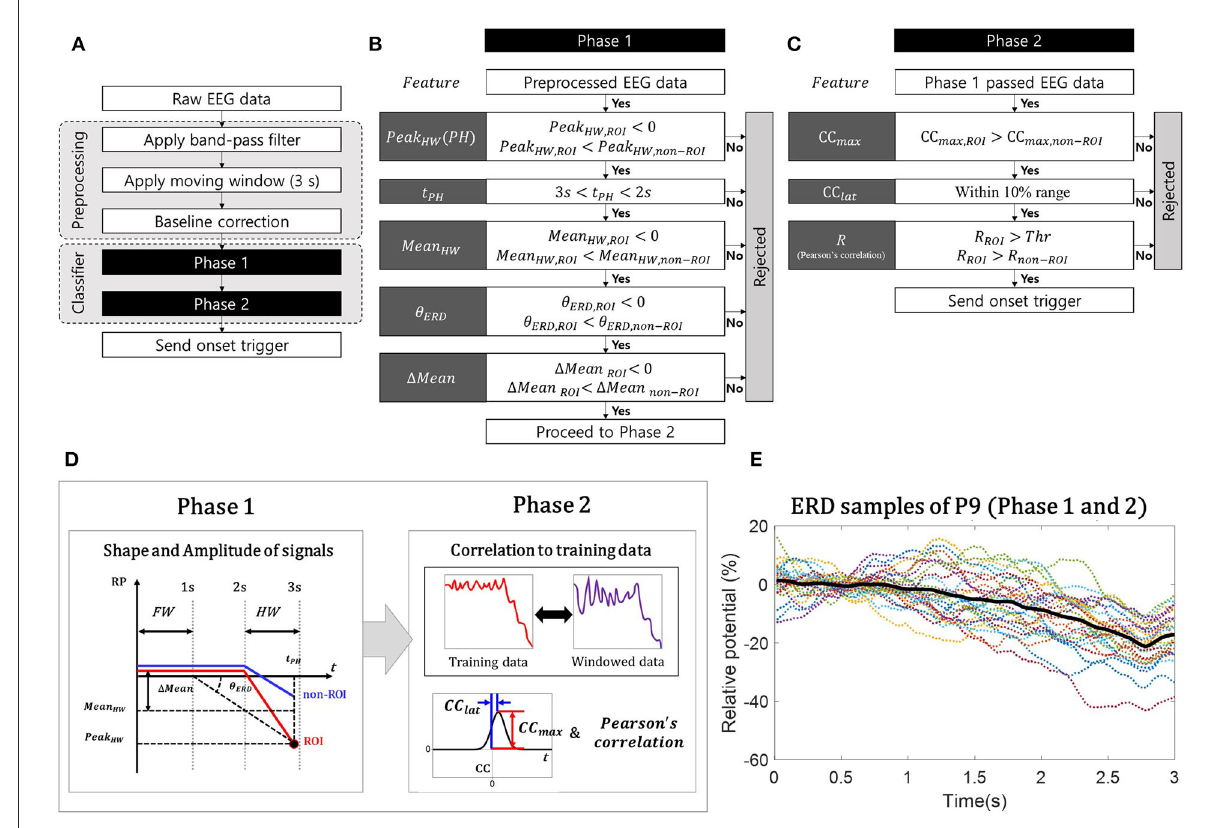
FIGURE2 Simple illustrations of two-phase classifier algorithm. (A) Flow chart for the whole algorithm; (B) Flow chart for phase 1: an illustration of the event-related desynchronization (ERD)-like shape of the band power relative potential (RP) signal and its features; (C) Flow chart for phase 2: cross-correlation coefficients ( CC ), latency ( CC lat ), and Pearson’s correlation, R; (D) Structure of proposing classifier; and (E) Characteristic of ERD samples used in classifier training (participant P9).